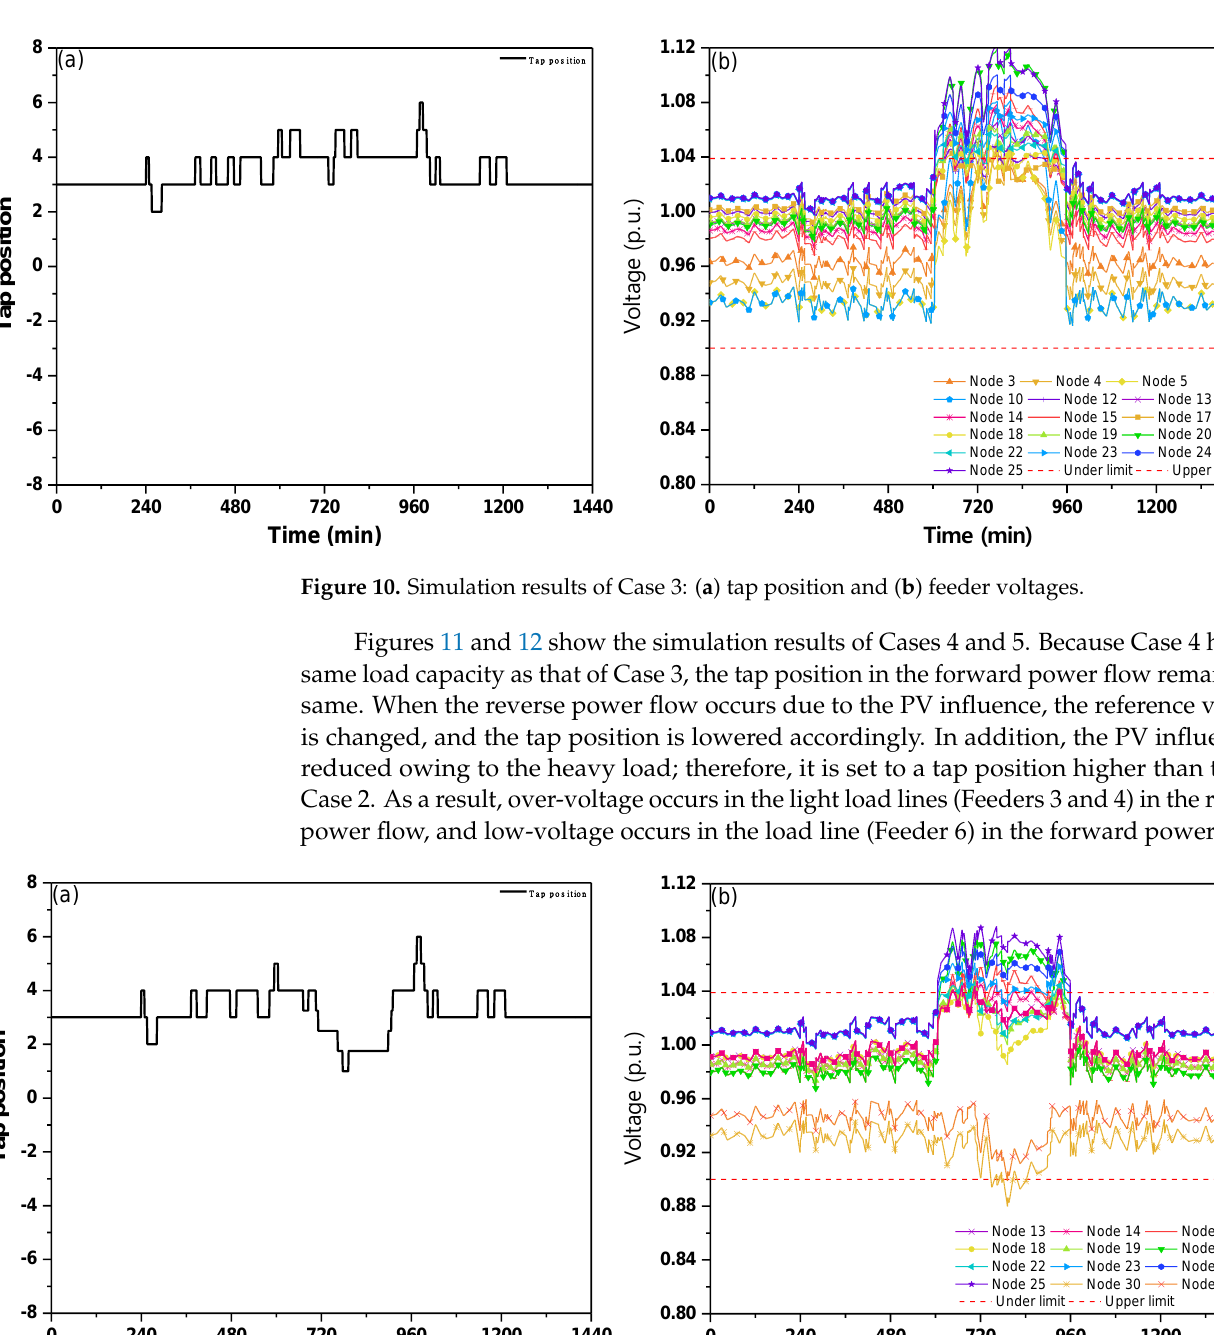
Figure 11. Simulation results of Case 4: ( a ) tap position and ( b ) feeder voltages. In Case 5, the voltage drop is small because the light load and tap position do not change owing to the dead band. In the reverse power flow, the tap position is increased with the increase in the reference voltage; however, in some sections where the PV output is at maximum, the negative tap position appears. As a result, a low-voltage problem occurs in the heavy load (Feeders 1, 2, and 5) during forward power flow, and over-voltage occurs in the line with large PV influence (Feeders 4,